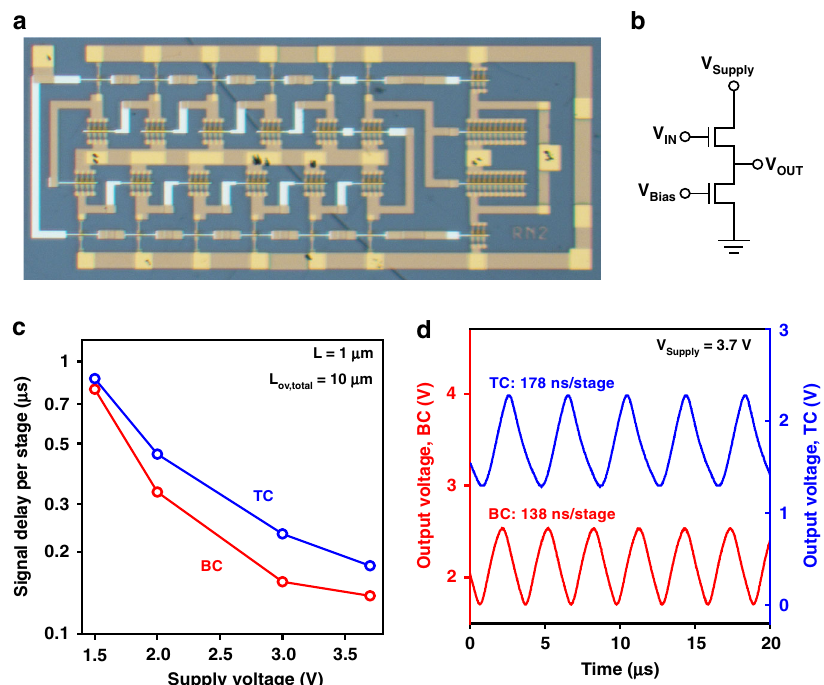
Fig. 8 Dynamic performance of unipolar ring oscillators on fl exible PEN substrates. a Photograph of an 11-stage unipolar ring oscillator based on bottom- contact DPh-DNTT TFTs with a channel length of 1 µ m and a total gate-to-contact overlap of 10 µ m. b Circuit diagram of the biased-load inverters TFTs plotted as a function of the supply voltage. d Output signals measured at a supply voltage of 3.7 V, showing stage delays of 178 ns for